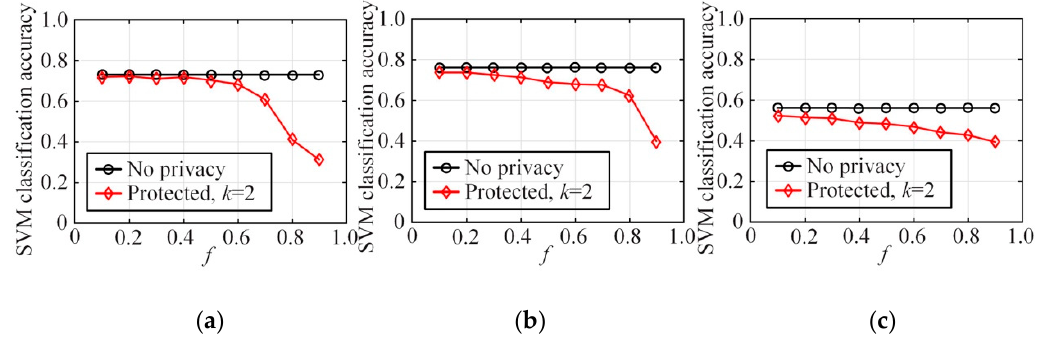
Figure 10. SVM classification accuracy by our method : ( a ) NLTCS, ( b ) Adults, ( c ) TPC-E.